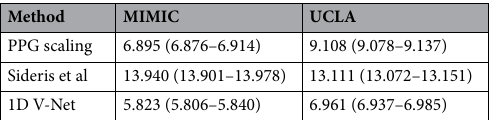
Table 2. Root mean square error (mean (95% CI)) for each cohort.